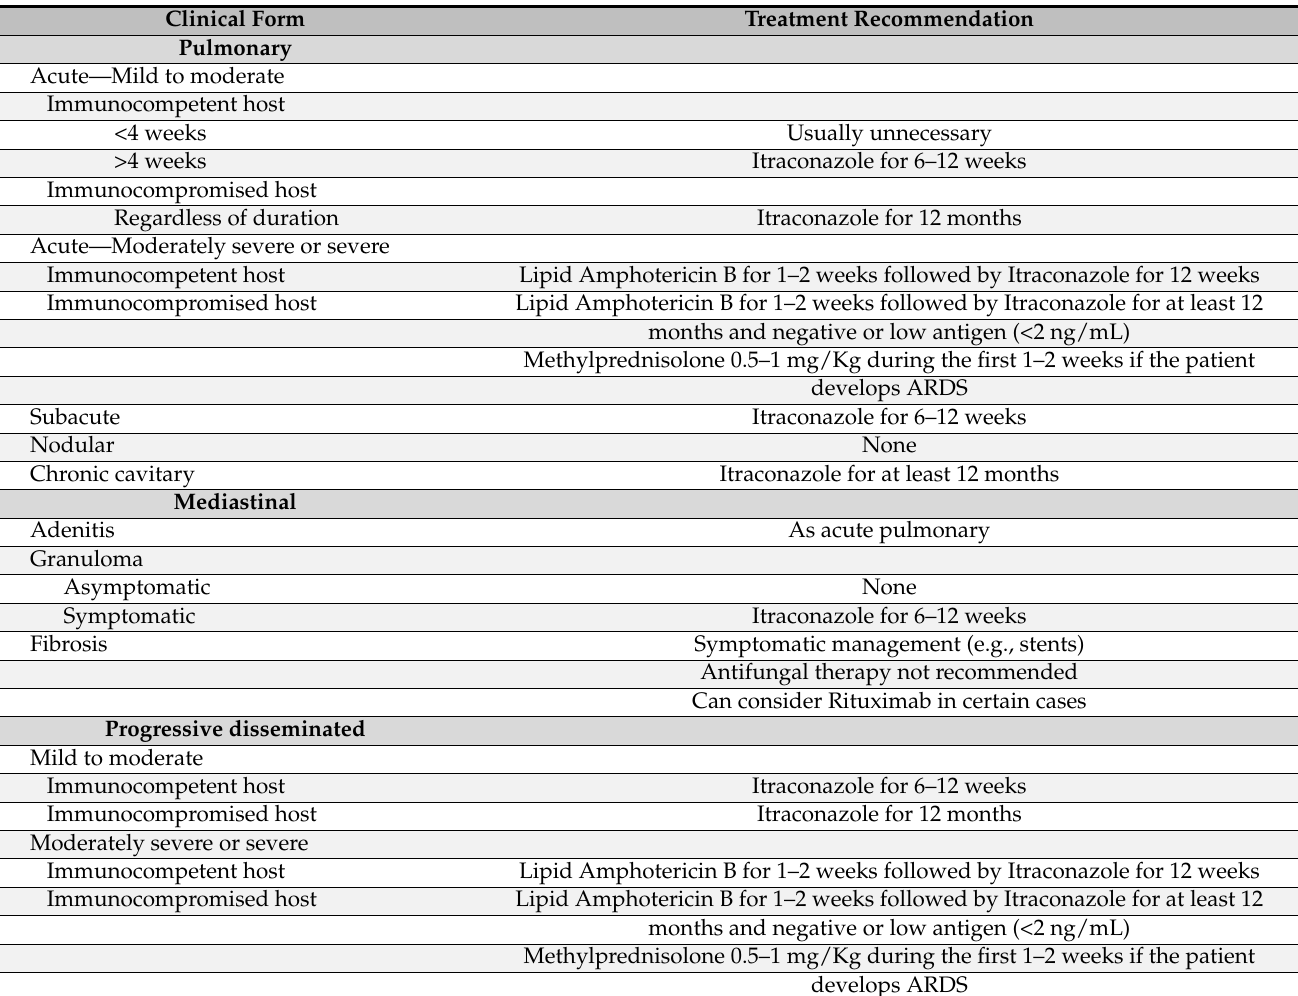
Table 3. Clinical forms and treatment